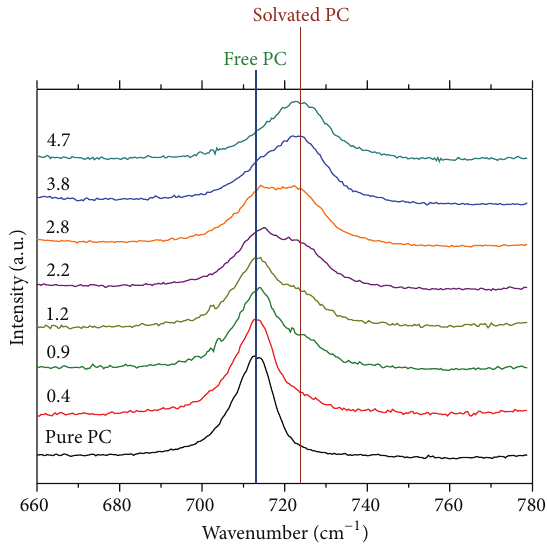
Figure 2: Raman spectra of pure PC and LiClO 4 -PC solutions of different concentrations. The concentration of all solutions is expressed as the molality of LiClO 4 (moldm −3 ) inside figure.